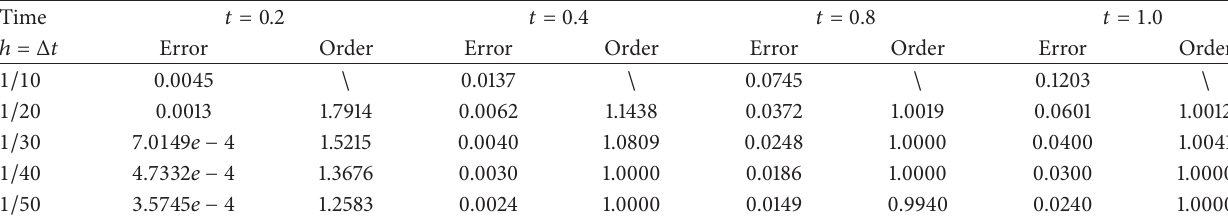
Table 2: The errors of ‖ p − p ℎ ‖ at different times.